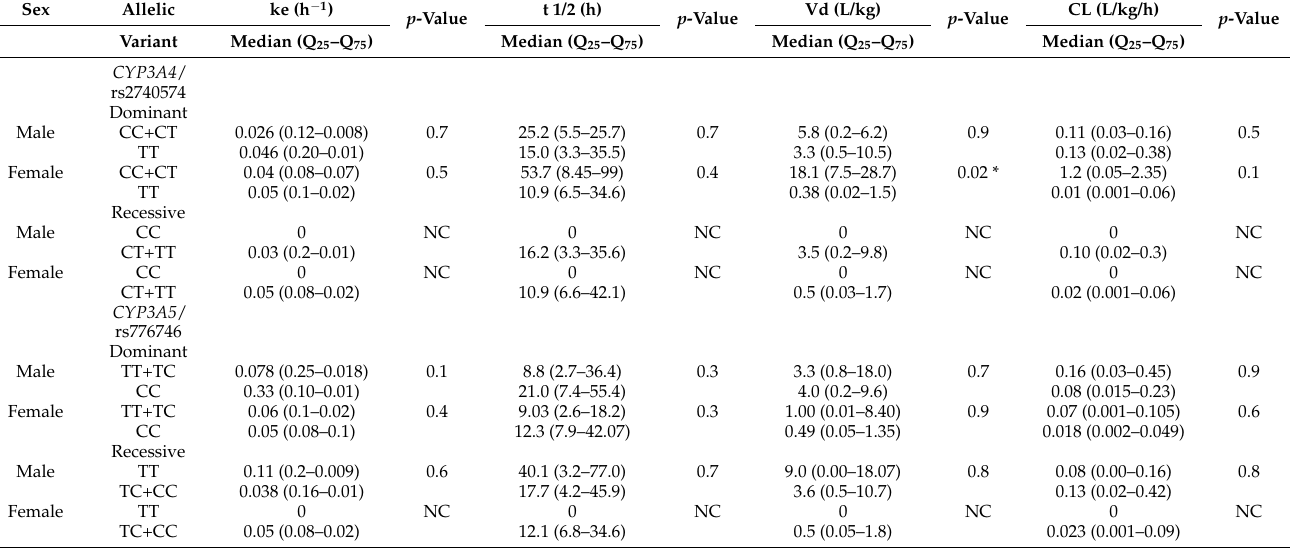
Table 4. Effect of the allelic variant on the pharmacokinetic parameters of midazolam stratified by